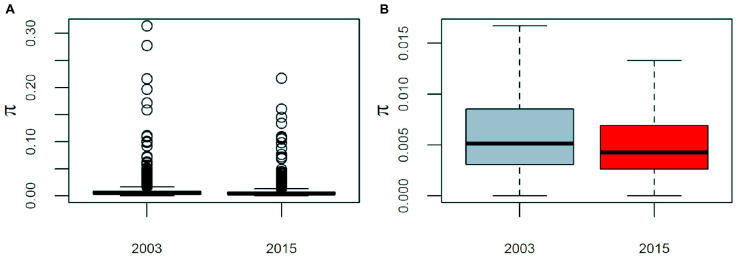
Boxplots of the average nucleotide diversity (π) of Pseudmonas otitidis at the global core genome level. The global core genome consists of 3,682 genes. Barplots are presented with (A) and with outliers (values outside 1.5 times the interquartile range) (B). The change of mean and variance of π are significant (paired two-sided Wilcoxon test: V = 4.42e6, p < 0.001; Brown-Forsythe test: F(1, 7362) = 27.6, p < 0.001).